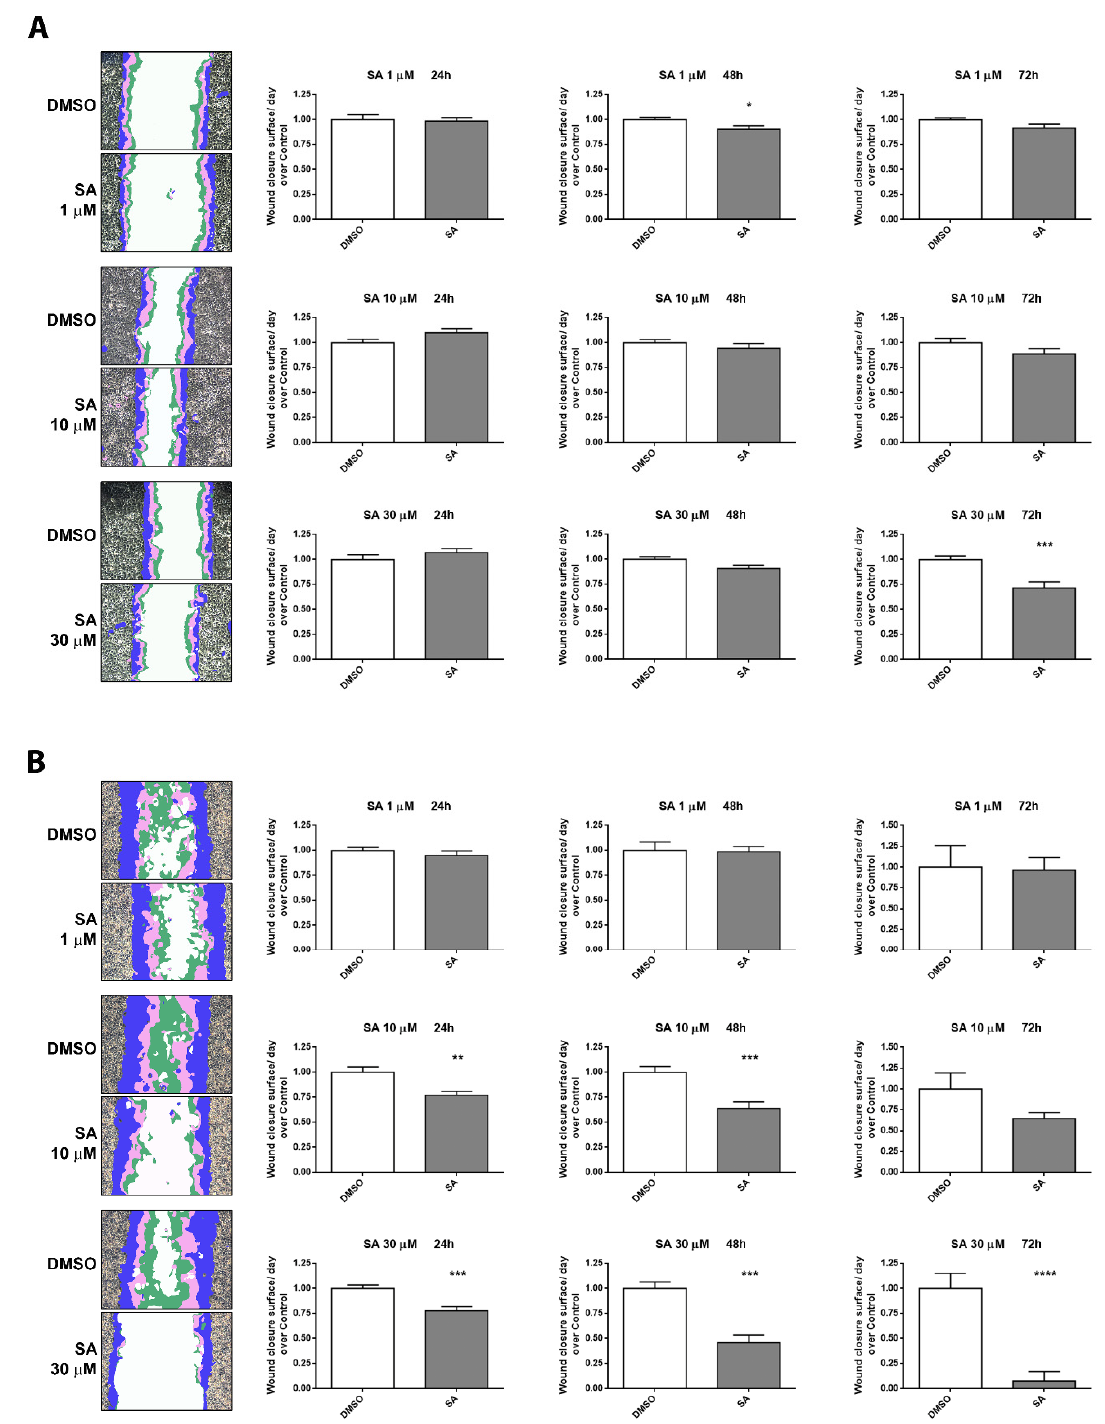
Figure 4. Sterculic acid disturbs wound healing in a dose-dependent manner. A549 ( A ) and H1299 ( B ) and cells were treated with SA at concentrations from 1 to 30 µM during 24 to 72 h in serum-free medium. Representative fields of wound healing area per day, where blue regions are the wound’s closed surfaces from 0 to 24 h, pink regions are the wound’s closed surface from 24 to 48 h, green regions are the wound’s closed areas from 48 to 72 h and white area represents the unclosed scratch region. In the graphs, white bars correspond to vehicle cell treatment (DMSO) while grey bars correspond to cells treated with SA (1–30 µM). Data represent mean ± SEM of closed area per day with respect to its DMSO control from at least two scratches of four independent biological replicates. * p < 0.05, ** p < 0.01, *** p < 0.001, **** p < 0.0001.